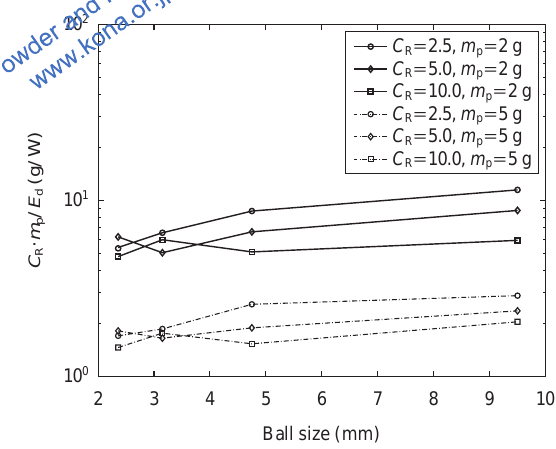
Theoretical/numerical milling dose based on the glancing energy dissipation rate as a function of ball